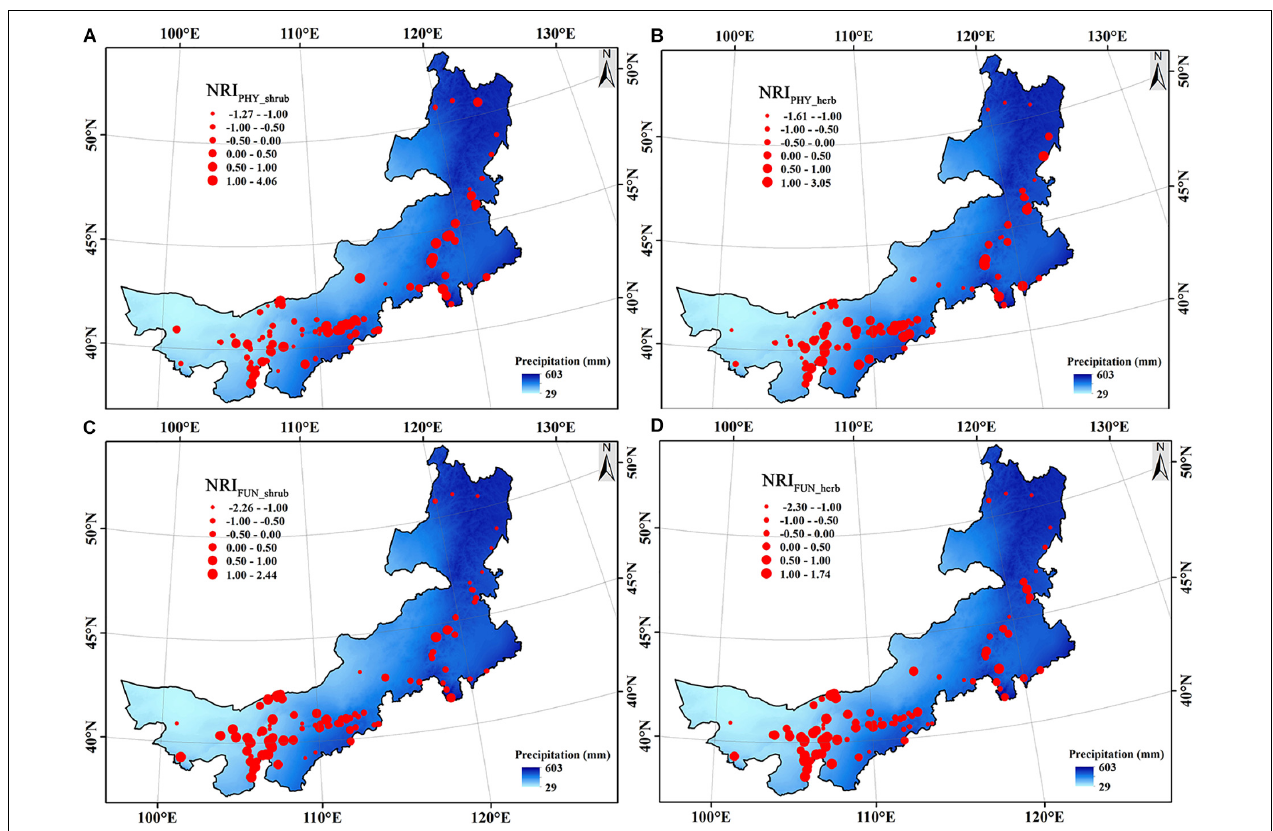
FIGURE 1 | The spatial distribution of the phylogenetic (A,B) and functional structure index (C,D) of each site along the modern precipitation gradient. All NRI values have been standardized in this figure. (A) the phylogenetic structure of shrubs (NRI PHY_shrub ), (B) the phylogenetic structure of herbs (NRI PHY_herb ), (C) the functional structure of shrubs (NRI FUN_shrub ), and (D) the functional structure of herbs (NRI FUN_herb